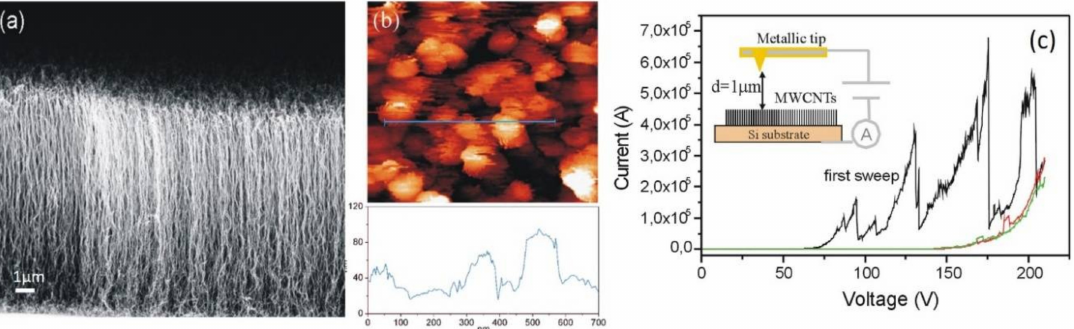
Figure 4. ( a ) SEM image (lateral view) of vertically aligned MWCNTs, grown by catalytic chemical vapor deposition on a silicon substrate with Ni catalyst. ( b ) Scanning Probe Microscopy imaging of 1 µ m × 1 µ m area of the film surface. Lower plot corresponds to the profile of solid line represented on the image. ( c ) Field emission current versus voltage measured at 1 µ m cathode–anode separation and pressure of 2 × 10 − 8 mbar. After a first sweep from 0 to 200 V the I – V characteristic remains stable for successive sweeps. Adapted with permission from [32], Copyright Elsevier,